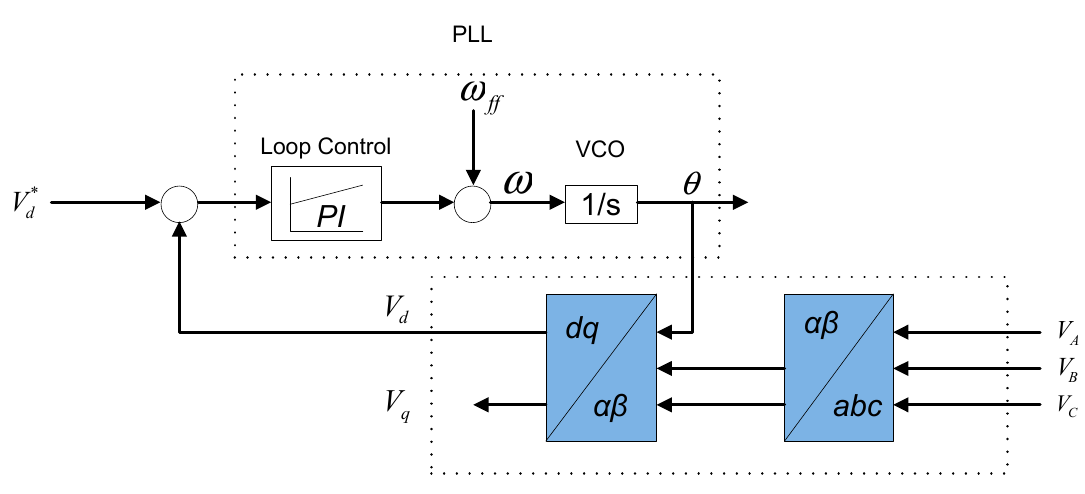
Figure 17. Three-phase SRF-PLL for grid synchronization.